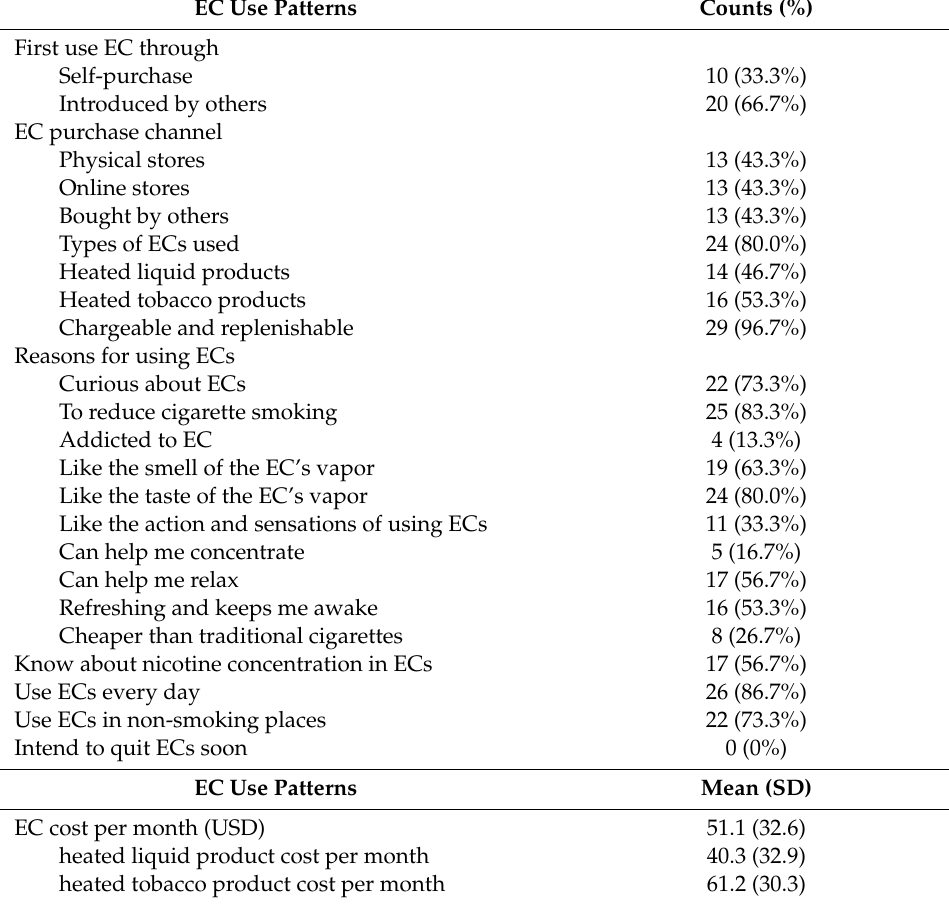
Table 2. Patterns and reasons for using ECs among the participants ( n =